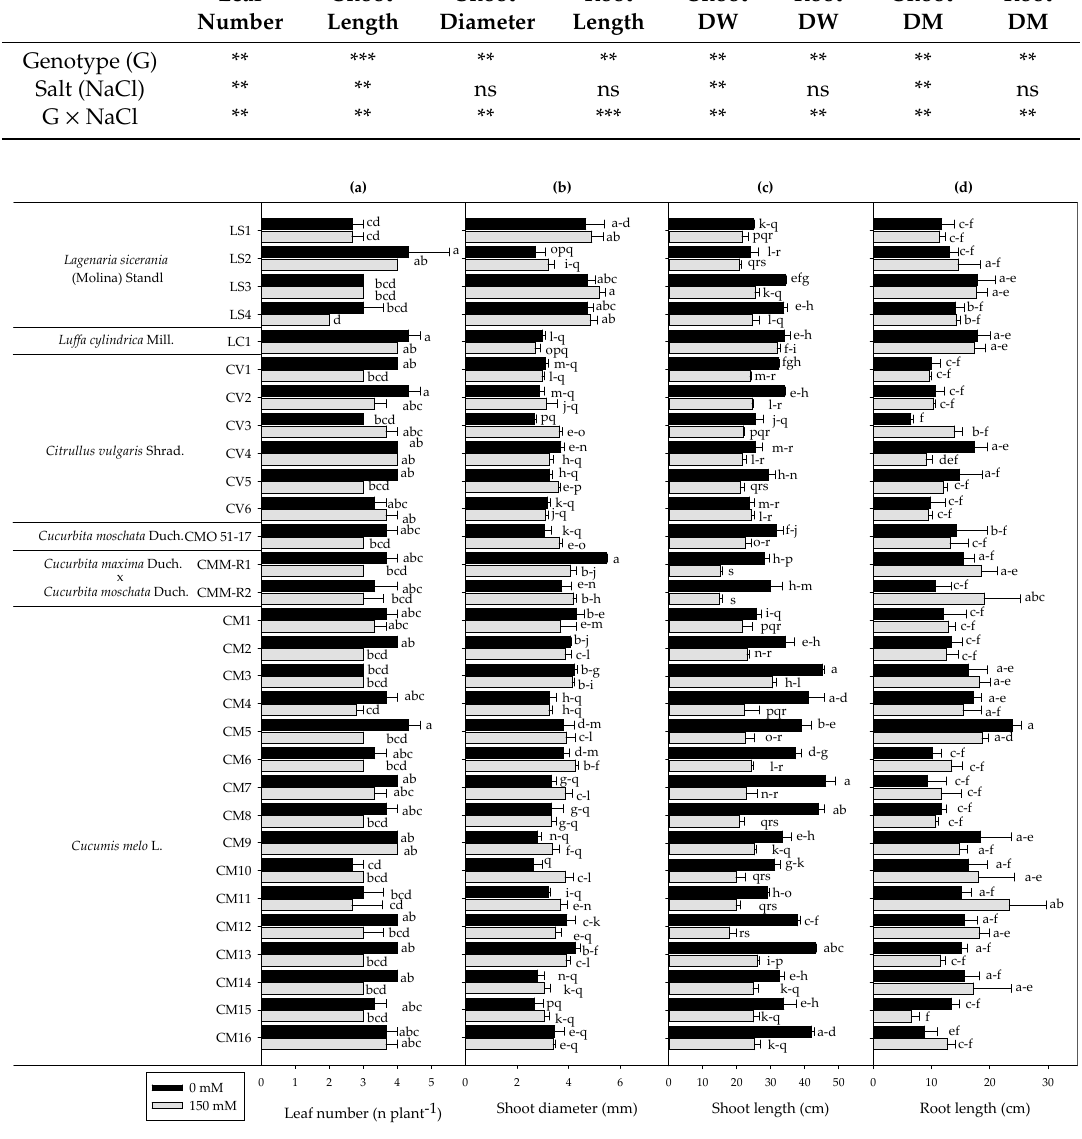
Figure 1. Plant growth, after one week of NaCl treatment, in term of number of leaves ( a ), shoot diameter ( b ), shoot length ( c ), and root length ( d ) in seedlings of sixteen Cucumis melo L, six Citrullus vulgaris Schrad., two C. maxima x C. moschata , four Lagenaria siceraria (Molina) Standl. different genotypes, and Cucurbita moschata Duch. cv 51–17 and Luffa cylindrica Mill. Mean values ± standard errors; n = 3 followed by different letters within each parameter are significantly different based on Duncan post hoc ( p < 0.05).